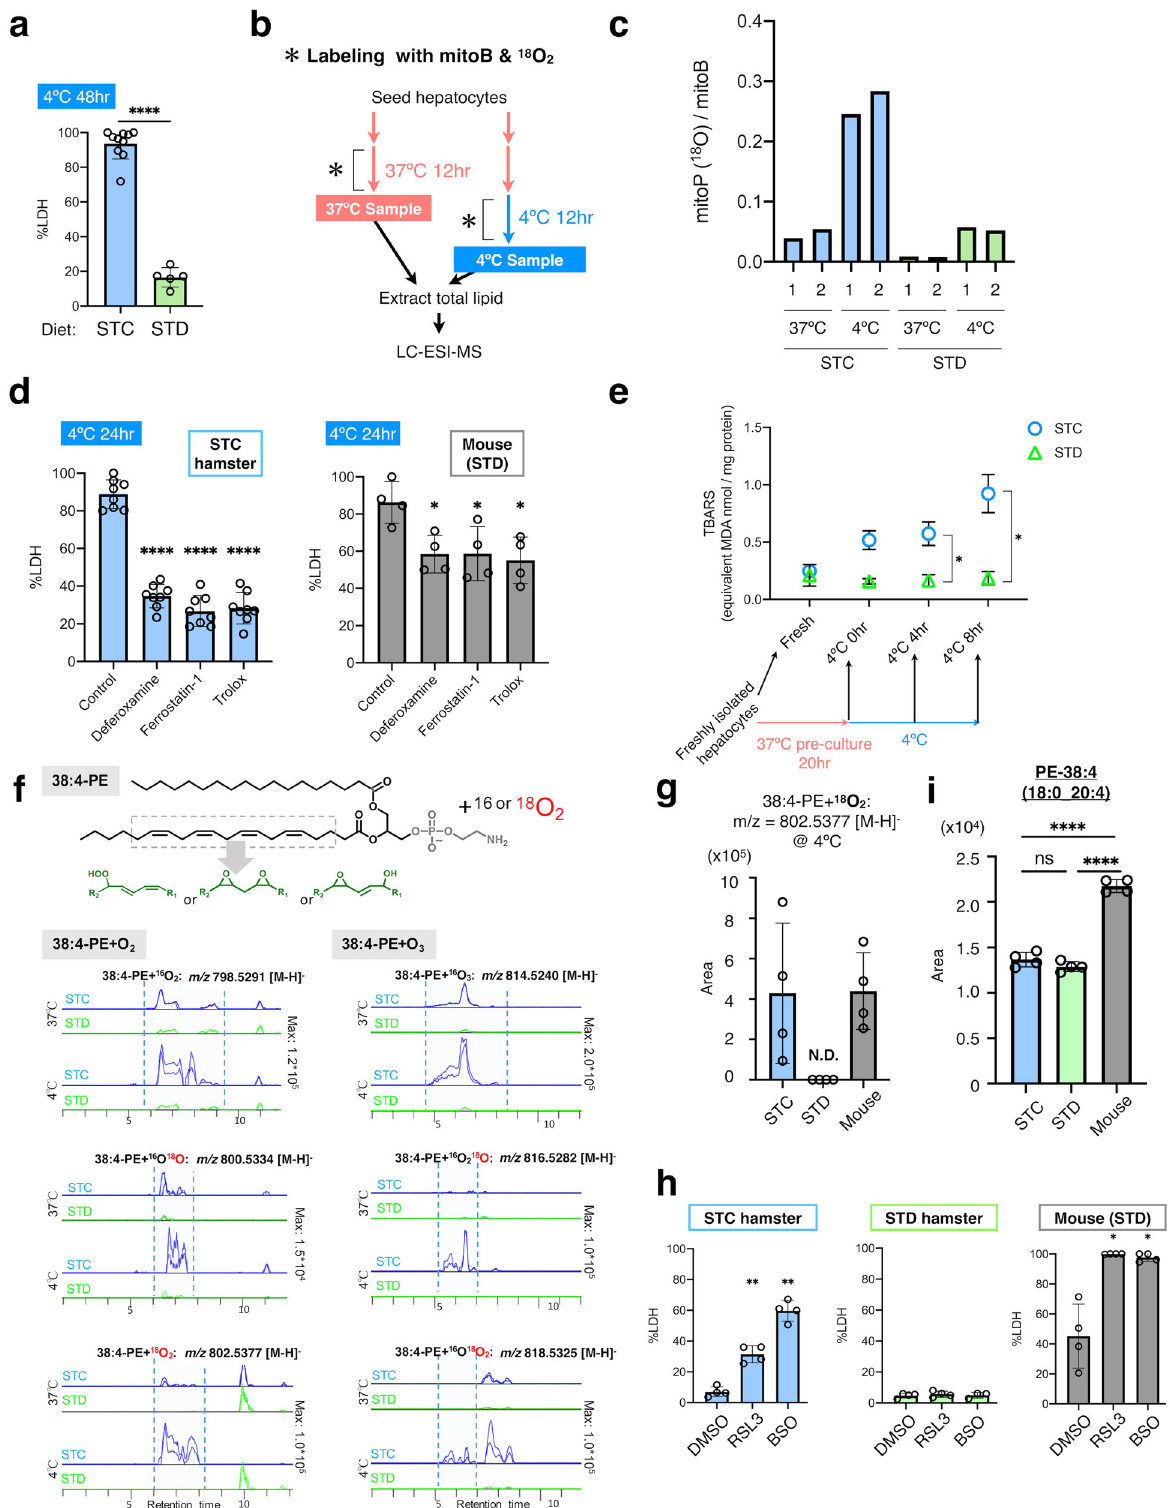
lipids extracted from freshly isolated hepatocytes was also con- ducted to compare two major PL classes, PL-PC, and PL-PE. Principle component analysis revealed a clear difference in the PC and PE lipid compositions between the mice and the two groups of hamsters along the PC1 axis (Fig. 3a and Supplementary Data 3), even when the mice and STD hamsters were given the same STD diet. Most lipids that largely contributed to the PC1